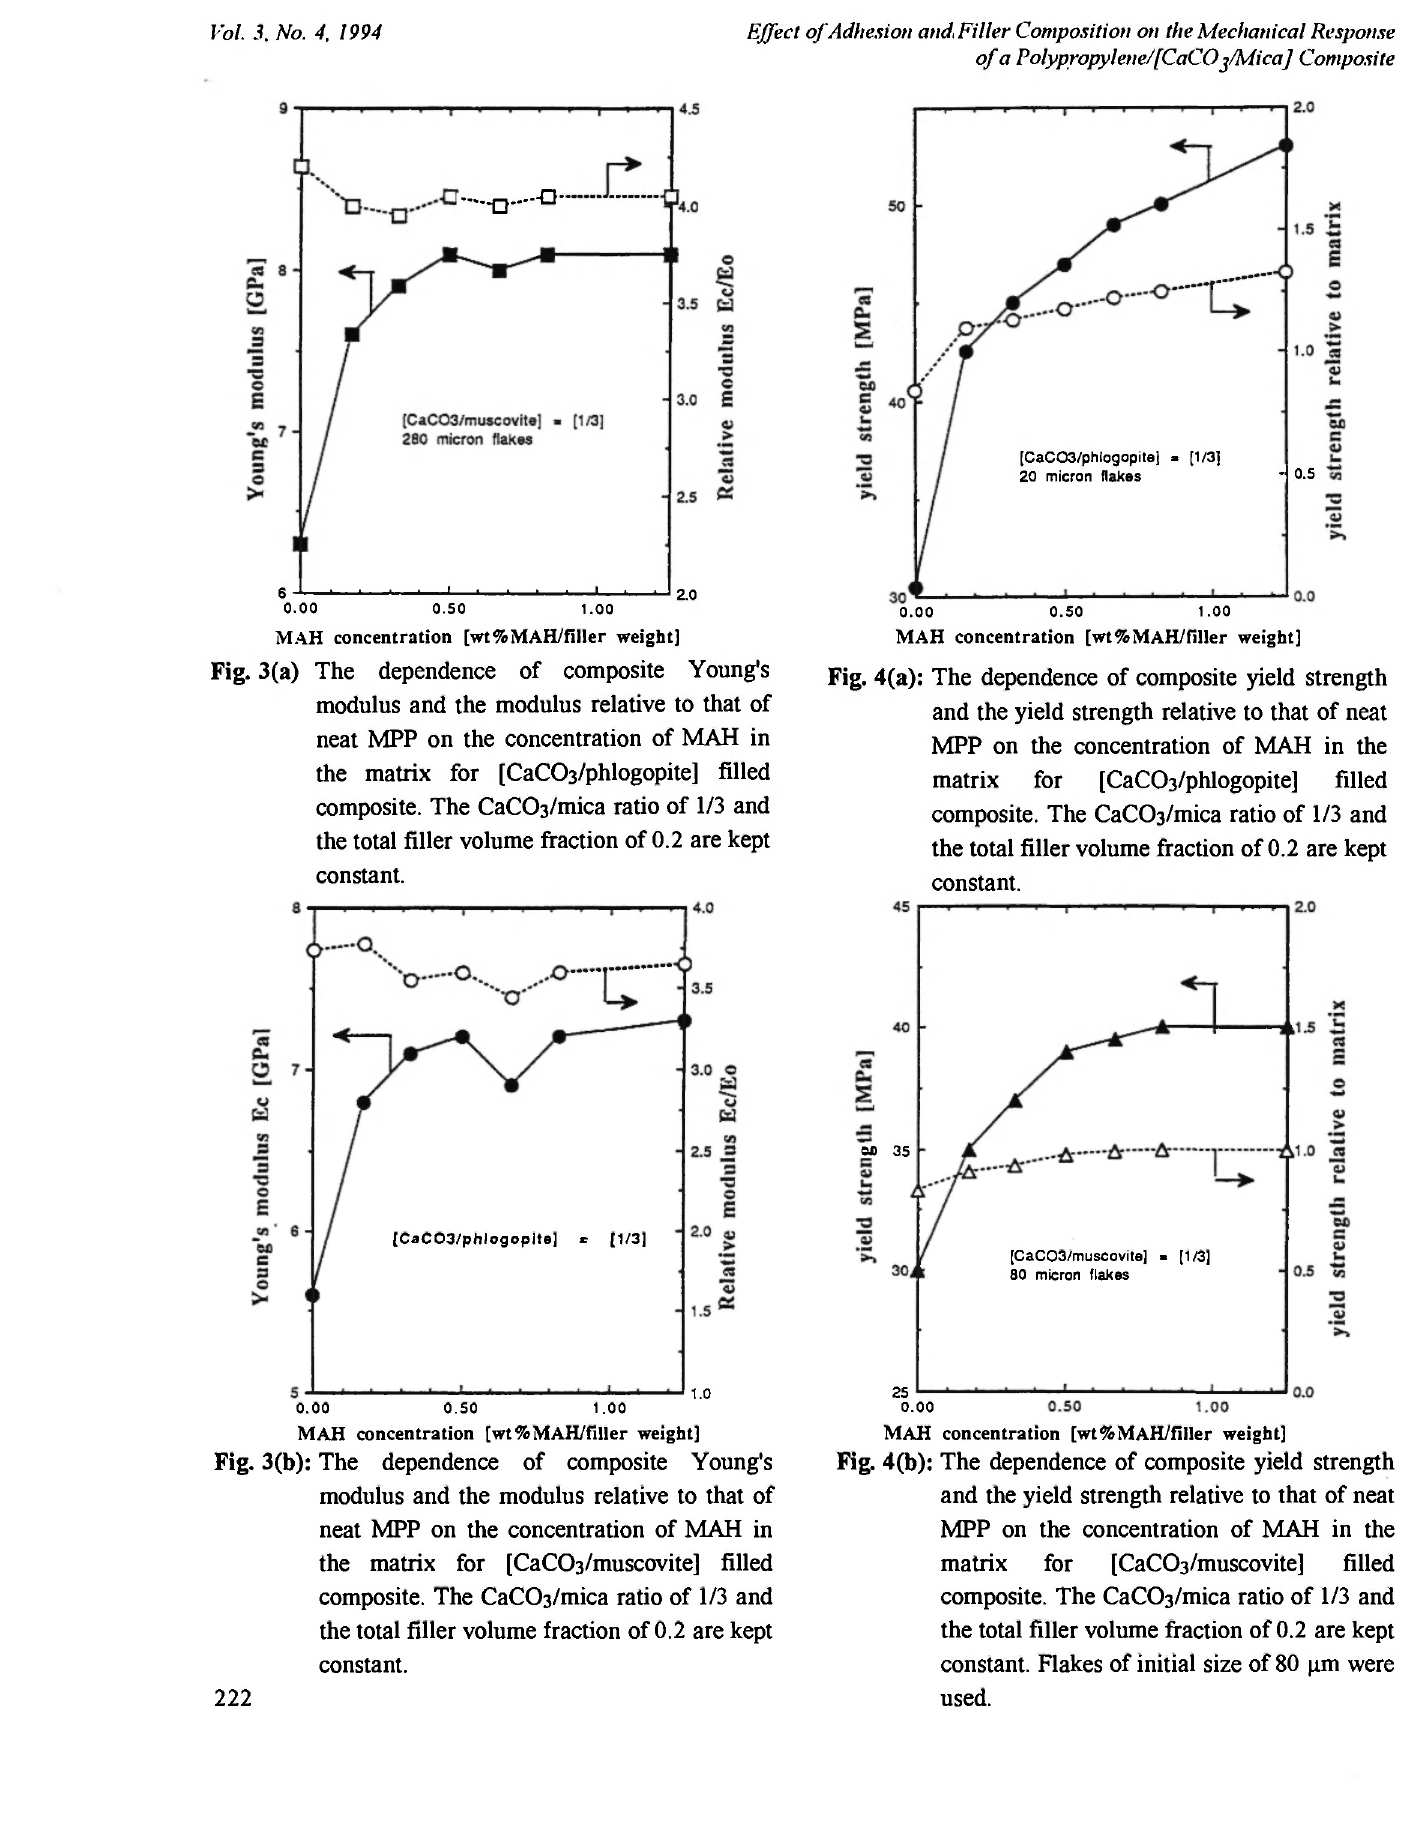
Fig. 3(b): The dependence of composite Young's modulus and the modulus relative to that of neat MPP on the concentration of ΜΑΗ in the matrix for [CaCOs/muscovite] filled composite. The CaC03/mica ratio of 1/3 and the total filler volume fraction of 0.2 are kept